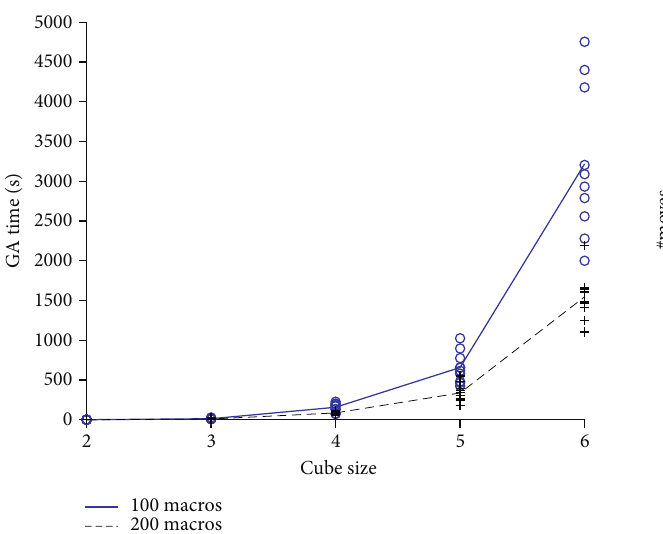
Figure 13: Solution length vs. cube ’ s